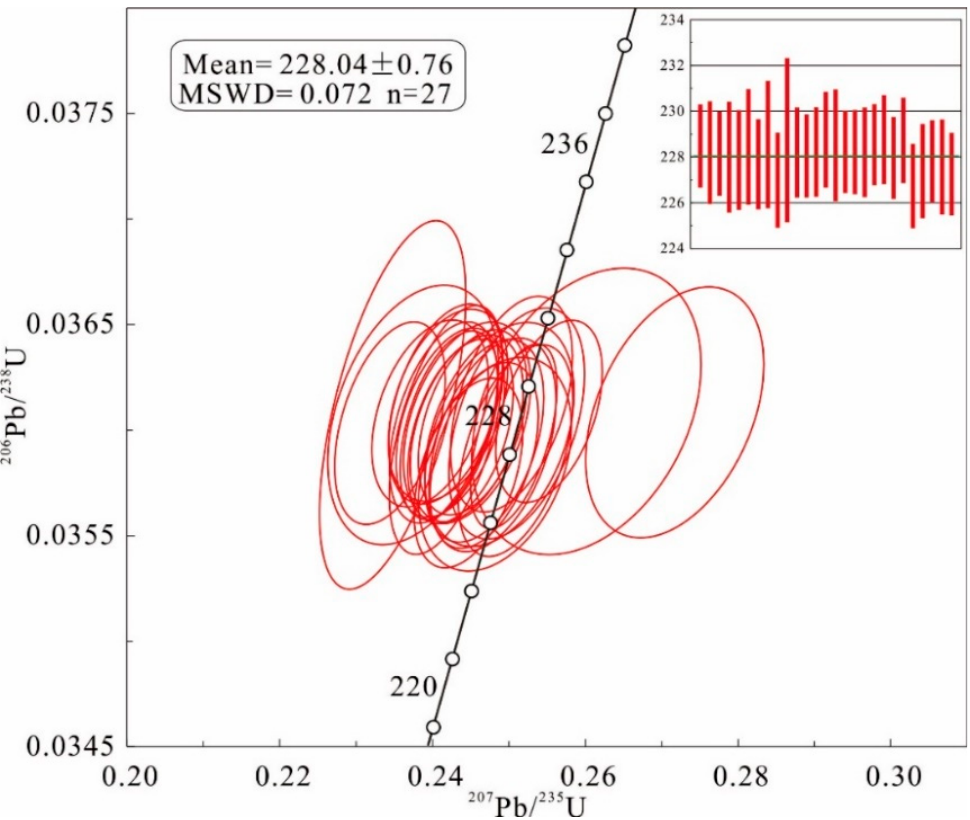
Figure 5. Zircon U-Pb Concordia and weighted mean ages of the Xiangcaoping granite.